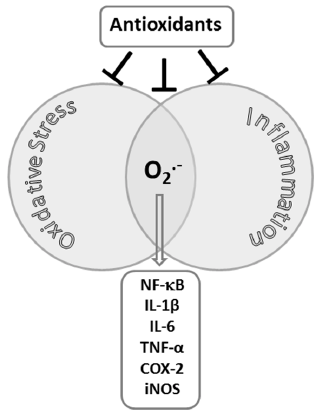
Figure 1. Interactions between oxidative stress and inflammation.